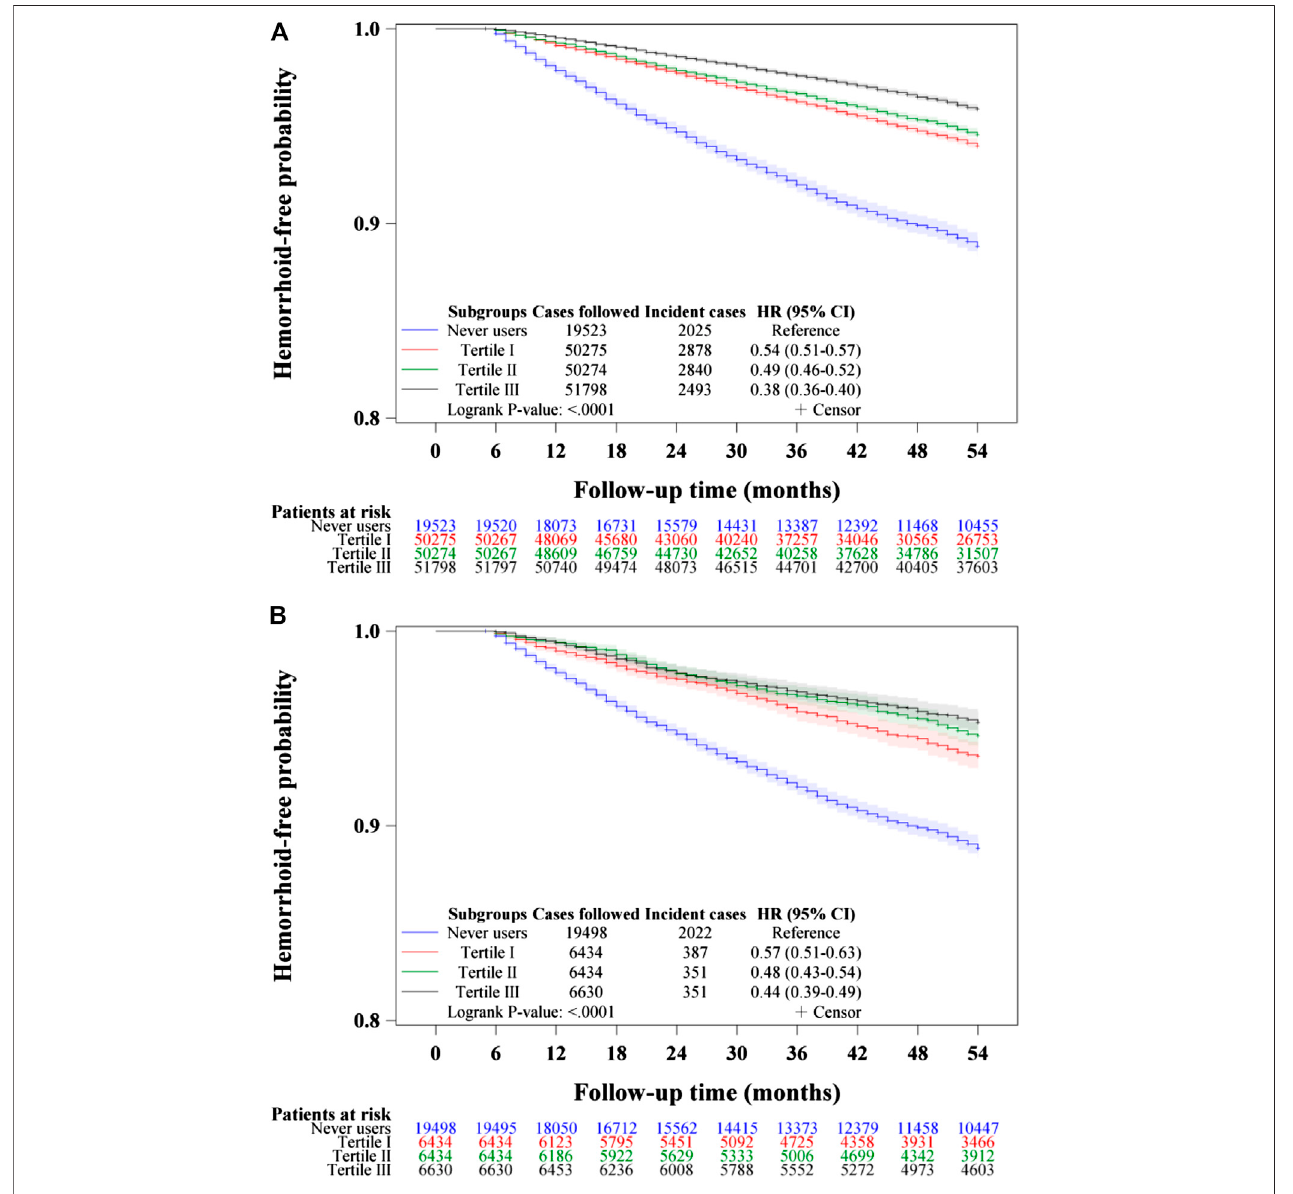
FIGURE 5 | Kaplan – Meier curves comparing hemorrhoid-free probability among never users and tertiles of units of de fi ned daily dose of metformin in the unmatched cohort (A) and the matched cohort (B) , respectively.